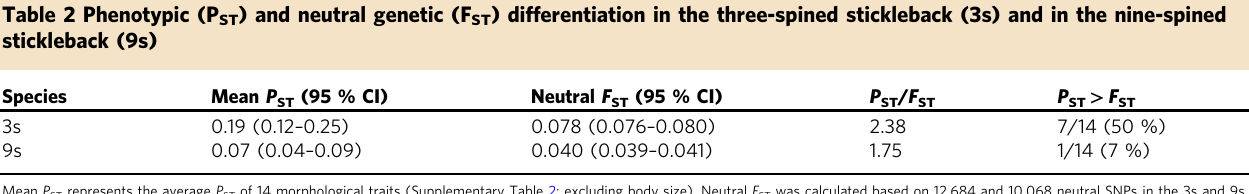
Mean P ST represents the average P ST of 14 morphological traits (Supplementary Table 2; excluding body size). Neutral F ST was calculated based on 12,684 and 10,068 neutral SNPs in the 3s and 9s stickleback, respectively. The ratio of mean P ST over neutral F ST ( P ST / F ST ) and the proportion of single-trait P ST values that signi fi cantly exceeded neutral F ST ( P ST > F ST ) are also shown